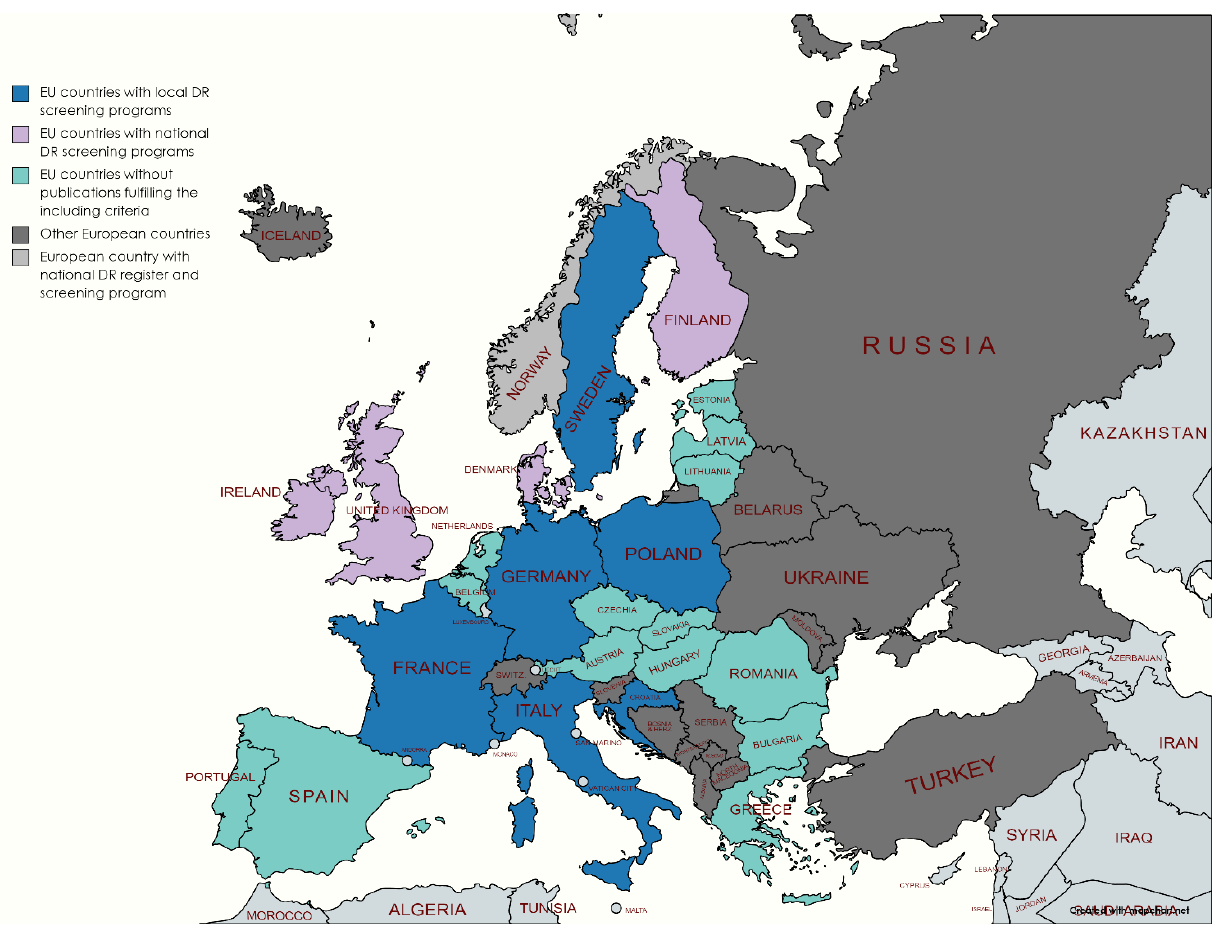
Figure 2. Geographical map of European countries based on presence of DR screening programs and